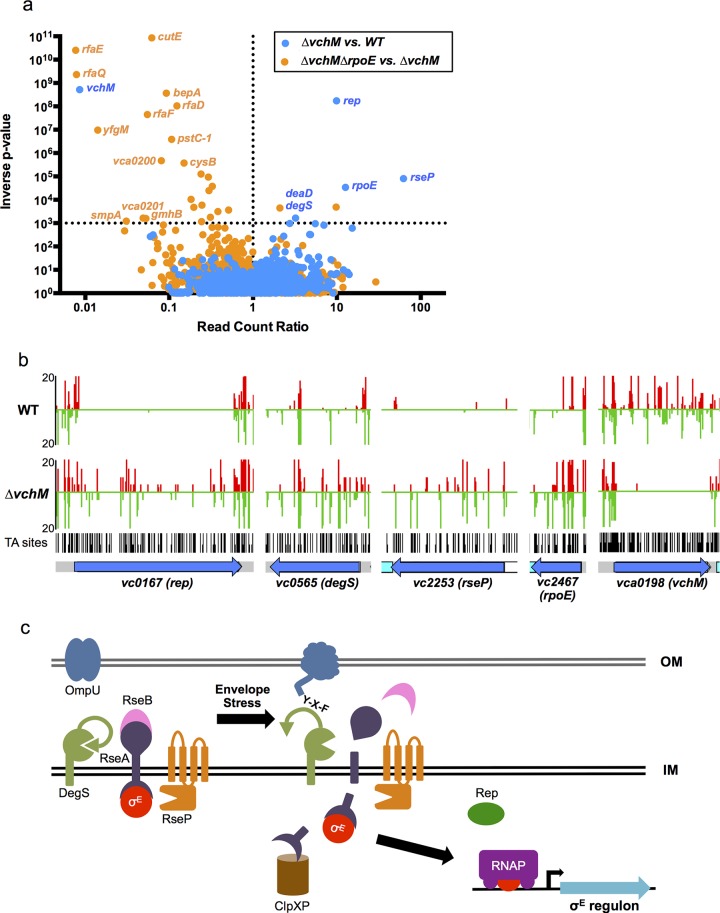
TIS-based identification of loci that interact genetically with vchM or rpoE.(A) For two comparative analyses (∆vchM vs. wt and ∆vchM ∆rpoE vs. ∆vchM), the read count ratio of transposons inserted into each genetic locus was determined, and is plotted against the inverse of the associated p-value as determined by Mann-Whitney U analysis of read counts. Genes plotted above the horizontal line are considered significantly different in each analysis (p-value <0.001). (B) The raw number of reads originating from insertions on the forward (red) or reverse strand (green) in wt and ∆vchM insertion libraries are shown for selected loci from both libraries. All potential insertion sites (TA dinucleotides) are marked by black bars. (C) The predicted σE stress response pathway in V. cholerae.